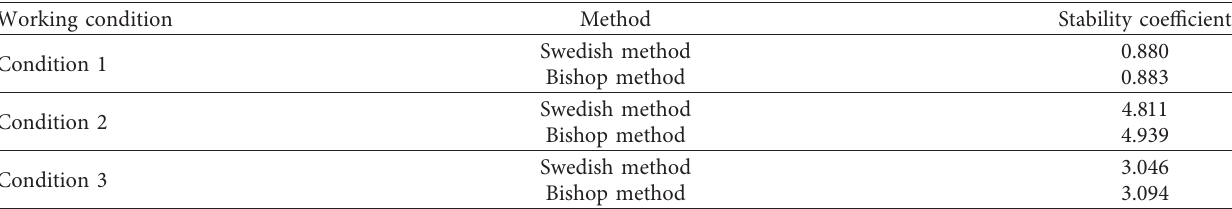
Table 6: Results of stability